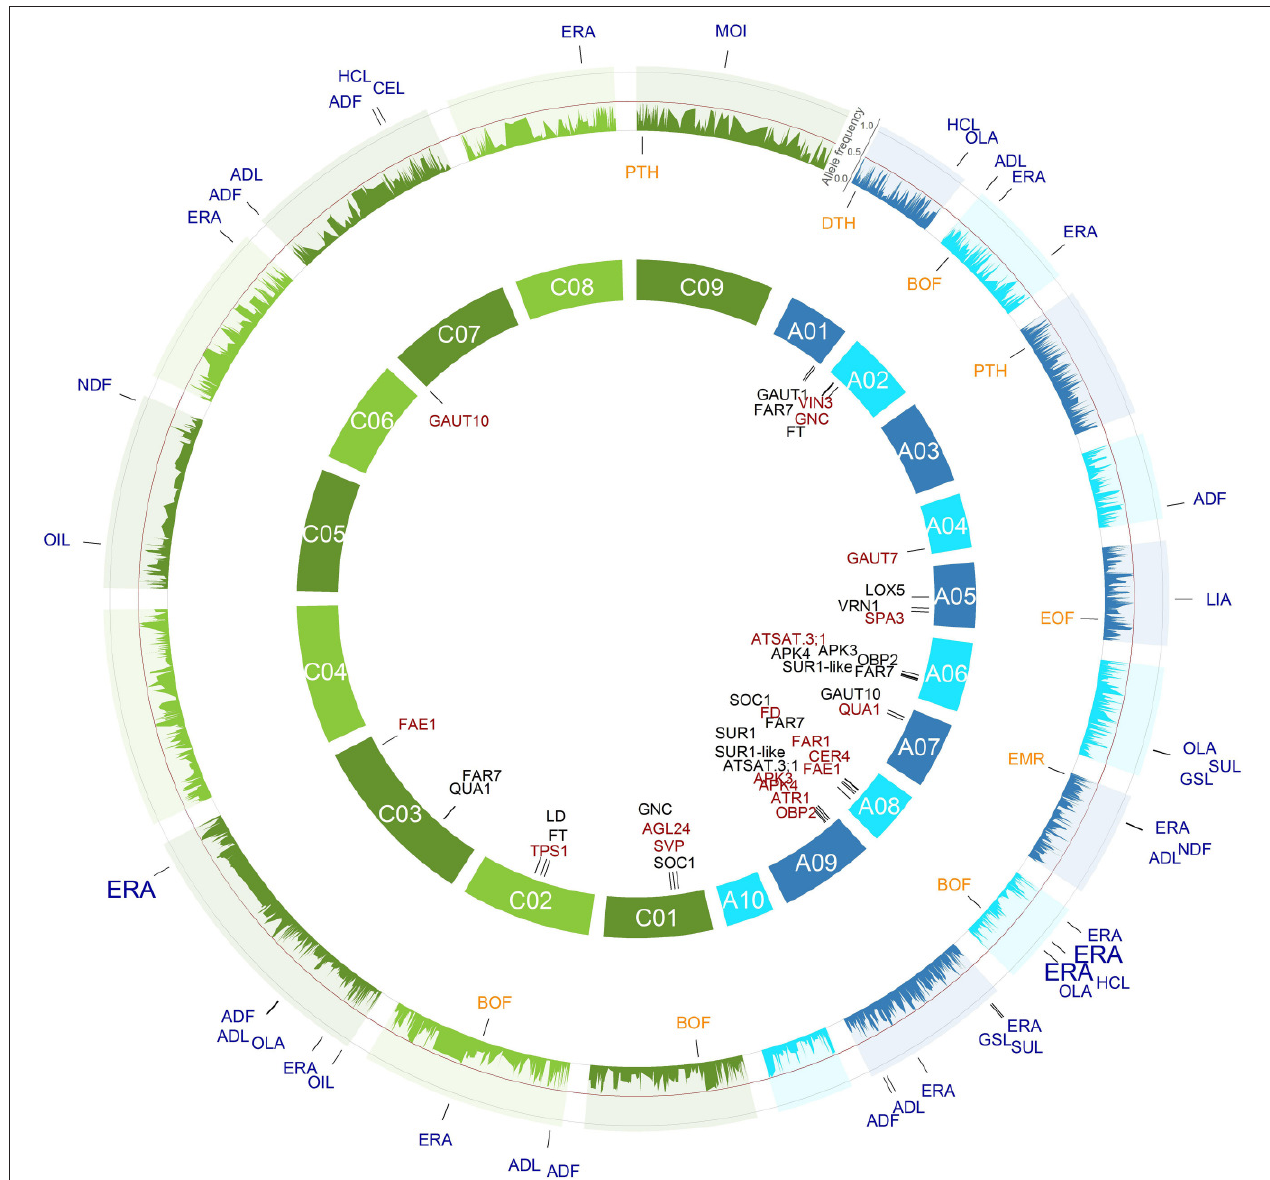
FIGURE 3 | All single nucleotide polymorphism (SNP)-trait associations with a P < 1.28e-05 (Bonferroni correction of α = 0.05) identified across the 184 inbreds of the spring trial and their respective positions are marked on the B. napus genome. The 3466 SNPs with their minor allele frequencies in the spring trial are given in the outer circle. The SNPs associated with the agronomic SNP-trait associations are plotted in orange below the allele frequency circle and the seed quality SNP-trait associations in blue outside the allele frequency circle. The size of the letters is related to the proportion of the variance explained by the associations. In the inner circle of the 19 chromosomes, the candidate genes were plotted to their mapping position on the B. napus reference genome. The A genome is colored blue and the C genome